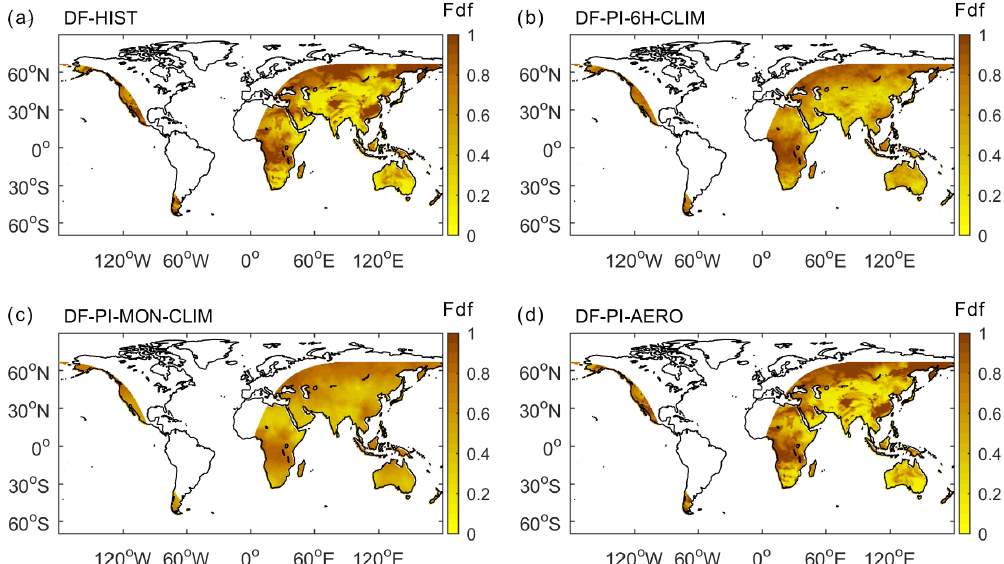
Figure 1. Fdf during 1 January 1901 at 00:00–06:00UTC from (a) the original forcing including climate variability from CRU-JRA and historical aerosol concentration (DF-HIST), (b) the 6h mean of 1 January at 00:00–06:00 Fdf over 1901–1920 non-volcanic years (DF- PI-6H-CLIM), (c) the monthly mean of January Fdf over 1901–1920 non-volcanic years (DF-PI-MON-CLIM), (d) the reconstruction using climate variability from CRU-JRA and mean 1901–1920 aerosol concentration (DF-PI-AERO). Nighttime pixels are masked for comparison.